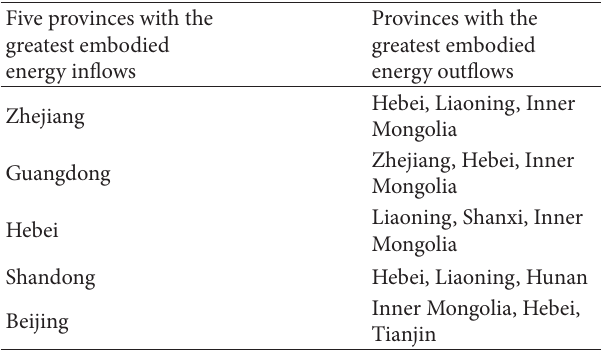
Table 7: Sources of embodied energy inflows into the top five pro-